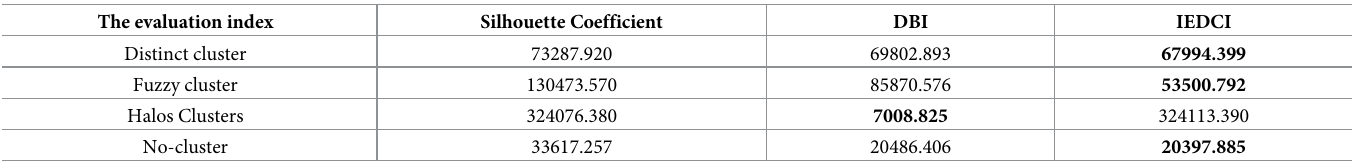
Table 6. Compactness evaluation results of different performance